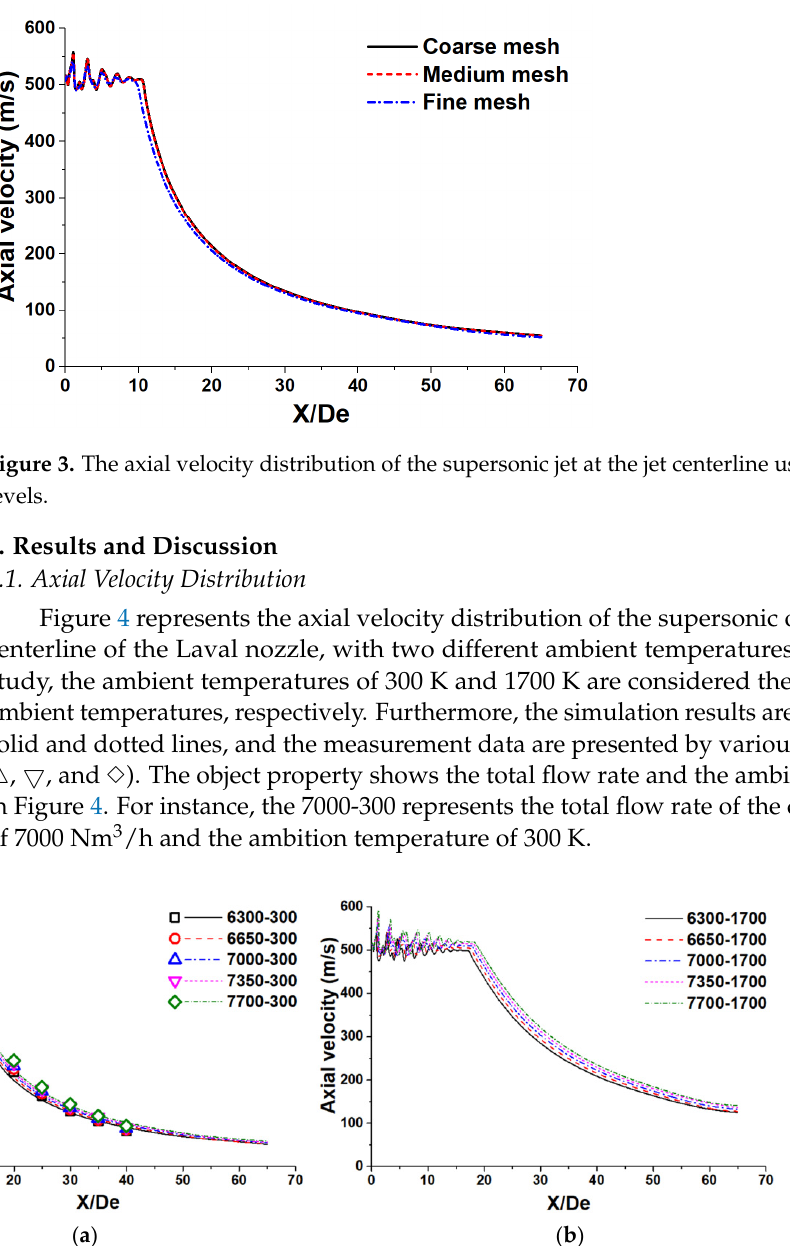
Figure 4. The axial velocity distribution of the supersonic jet at the Laval nozzle centerline: ( a ) room ambient tempera- ture; ( b ) high ambient temperature.